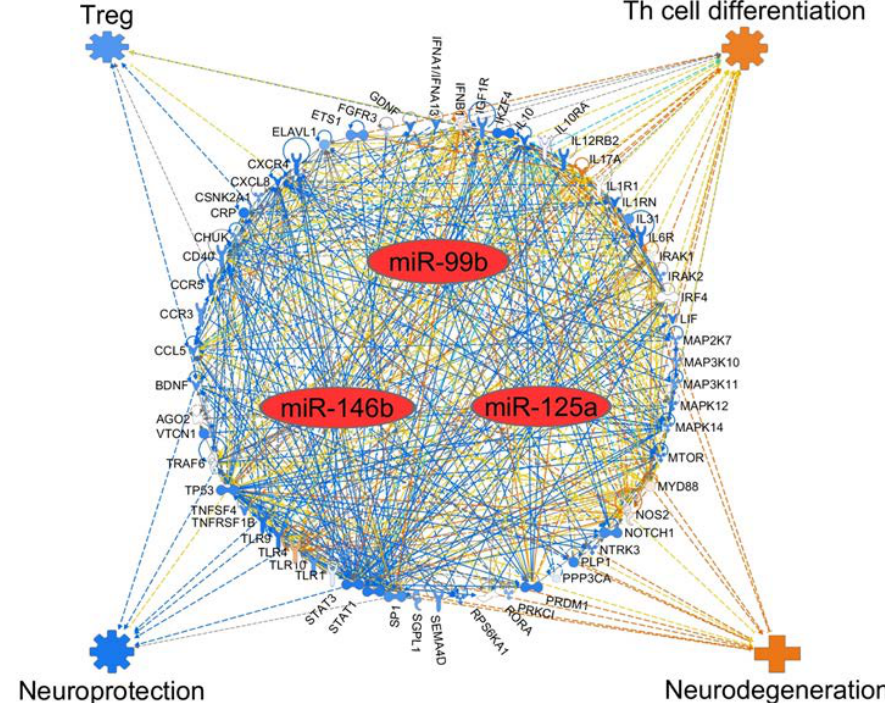
Figure 5. Network analysis of select miRNAs and their target mRNAs, as well as their impact on the disease process in multiple sclerosis. IPA-based schematic representation of various mRNA targets affected by the three major miRNAs altered during EAE development, namely miR-99b, miR-125a, and miR-146b, leading to differential effect on pathogenic versus protective T cell subset as well as neuroprotection versus neurodegeneration. The known interactions between the genes are represented by lines showing activation (arrow) or inhibition (blunt end). Further, solid line indicates direct interaction, whereas dashed line indicates indirect interaction. Colored lines indicate the following: orange line for activation, blue line for inhibition, yellow line for uncertain state of the downstream molecule, and gray line for effect not predicted. For the target genes, orange indicates predicted activation, whereas blue indicates predicted inhibition.